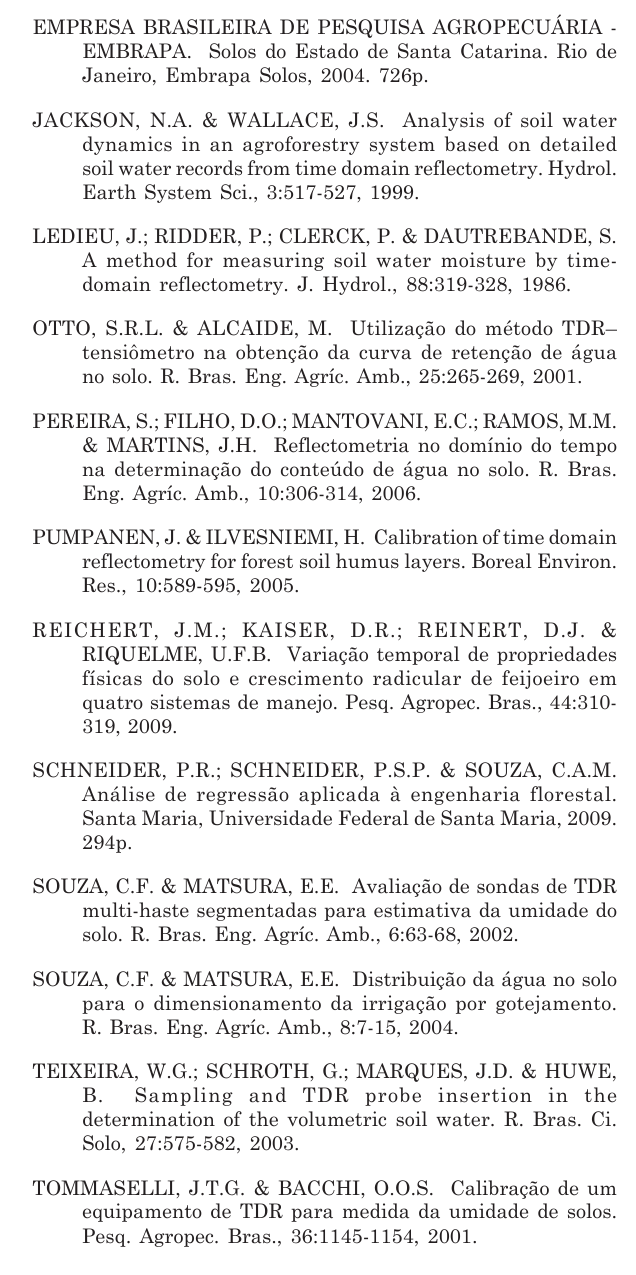
(1) Standard error of